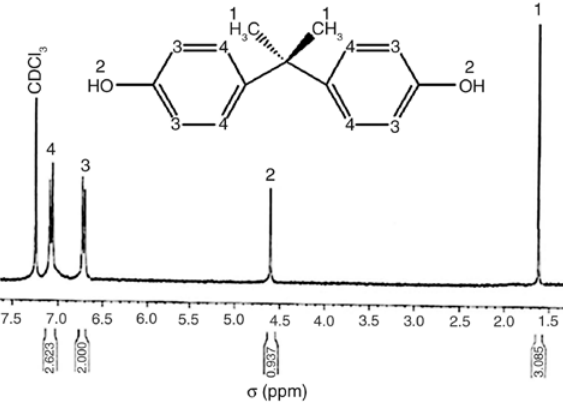
Scheme 8: 13 C NMR spectrum of recovered pure BPA in the CDCl 3